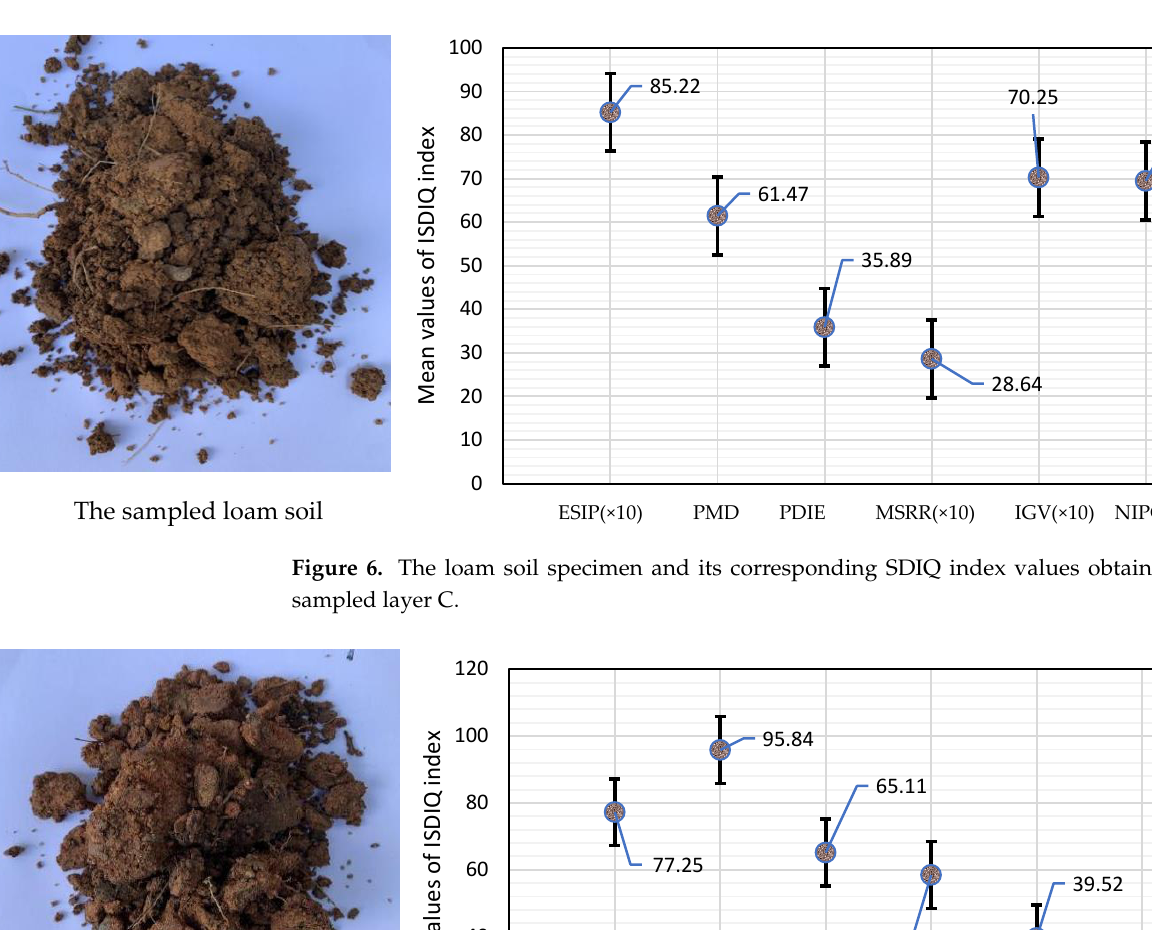
Figure 5. The loam soil specimen and its corresponding SDIQ index values obtained from the sampled layer B.